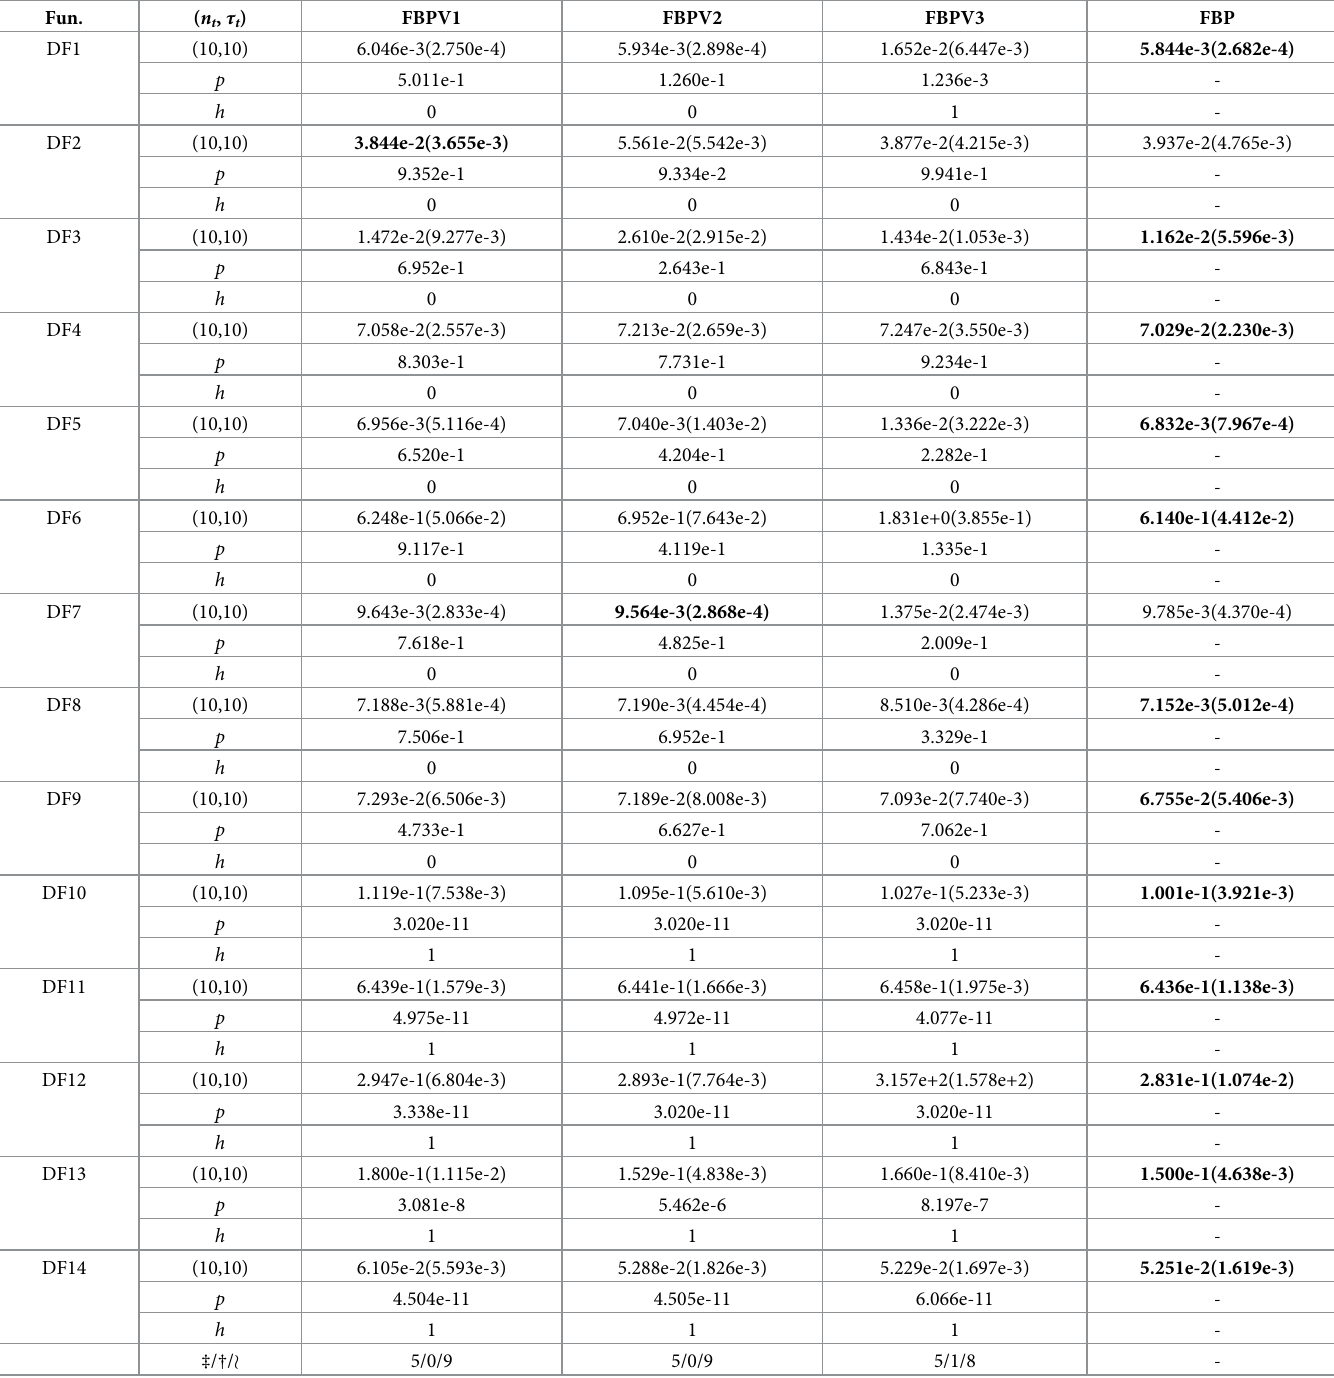
Table 13. Performance comparison of different FBP variants on MIGD.